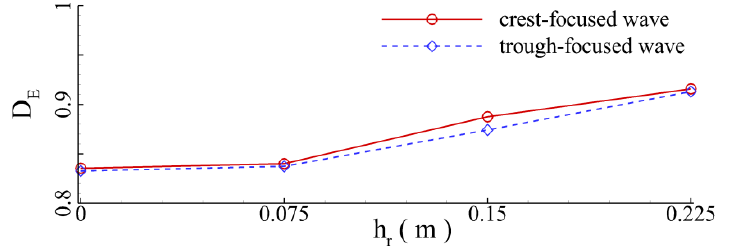
Figure 39. Wave energy dissipation rate versus the submergence water depth.